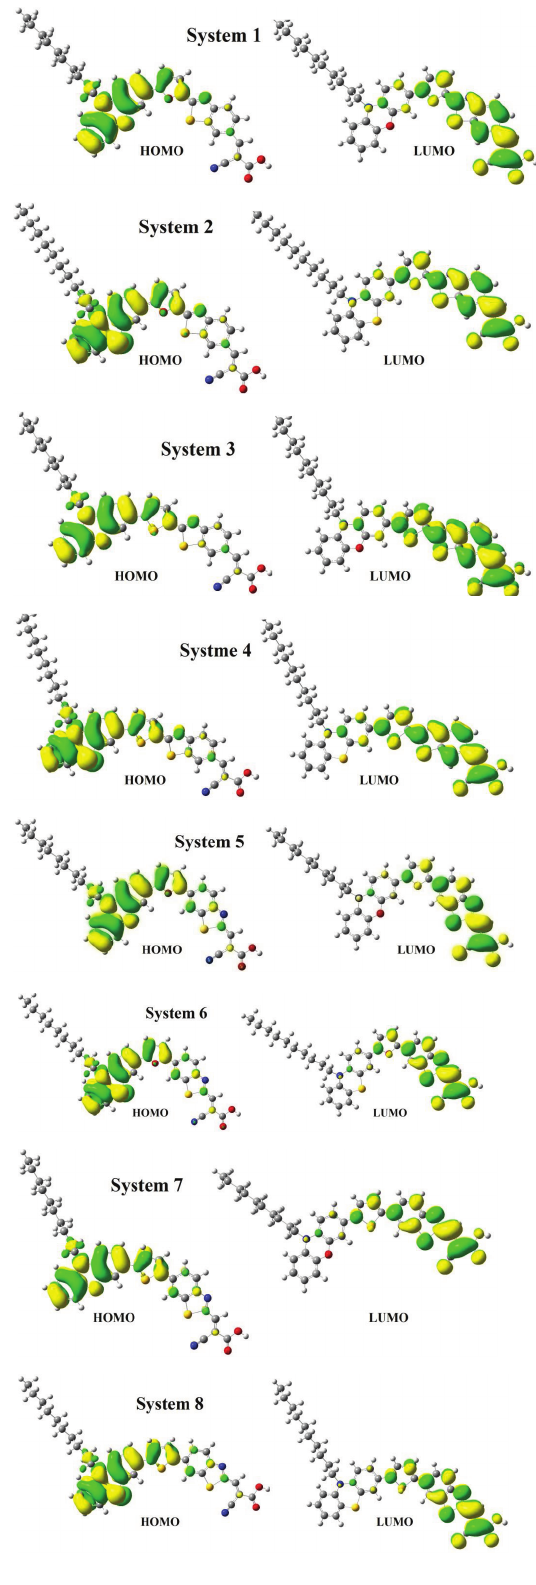
Figure 3 . HOMOs and LUMOs of systems Figure 3 : HOMOs and LUMOs of systems.